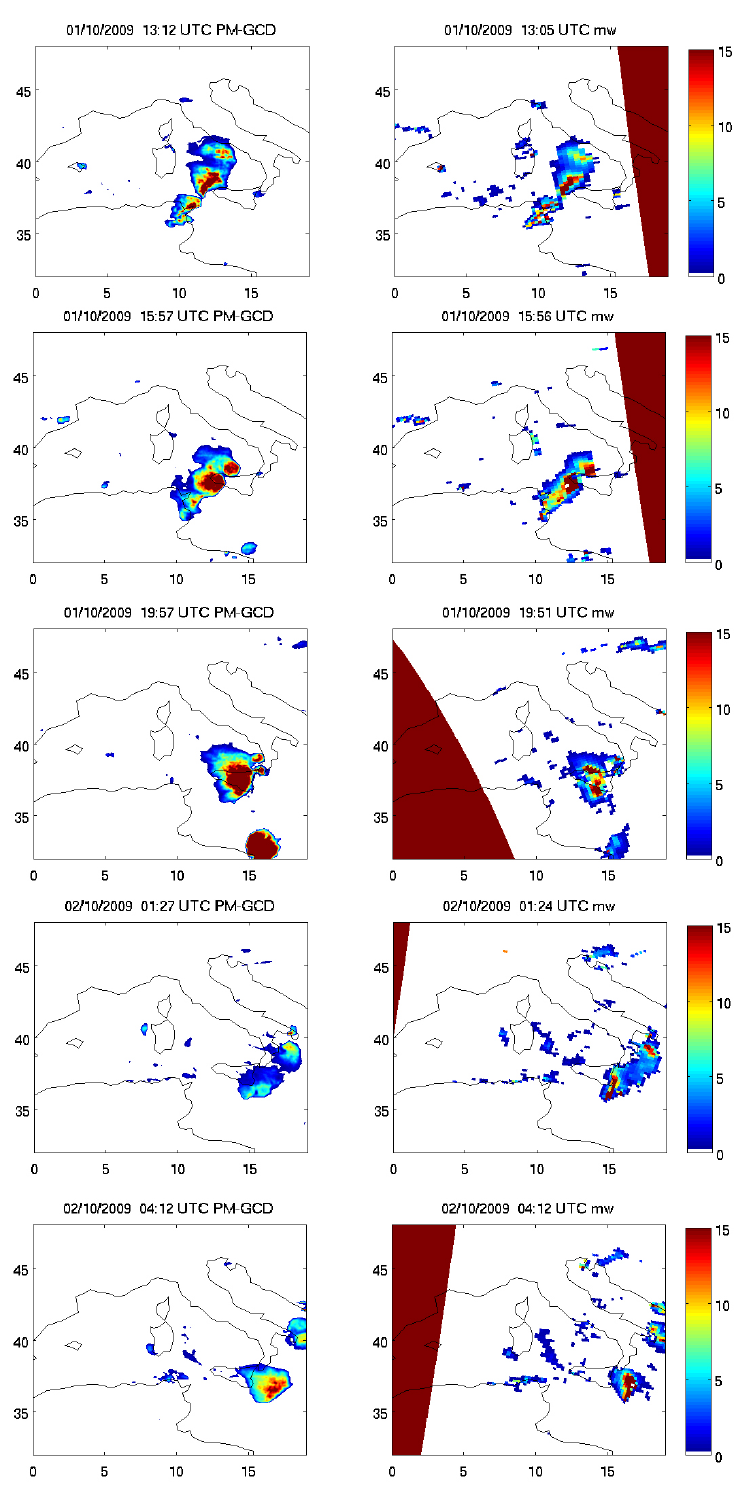
Fig. 8. Comparison of corresponding PM-GCD (left column) and AMSU-based (right column) rainfall rates (color scale in mmh − 1 ) for the selected case study. Each PM-GCD panel refers to the MSG observation which is closest to the corresponding AMSU overpass and is based on the calibration function that is computed for the previous AMSU overpass – i.e., from top to bottom: on 2 October 2009 at 13:01, 15:56, 19:51UTC and on 2 October 2009 at